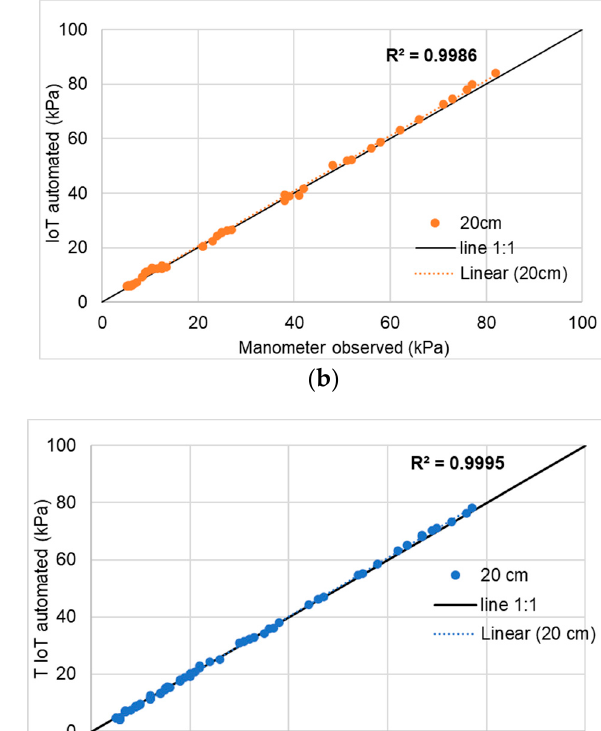
Table 1. Breakdown cost of the prototype.